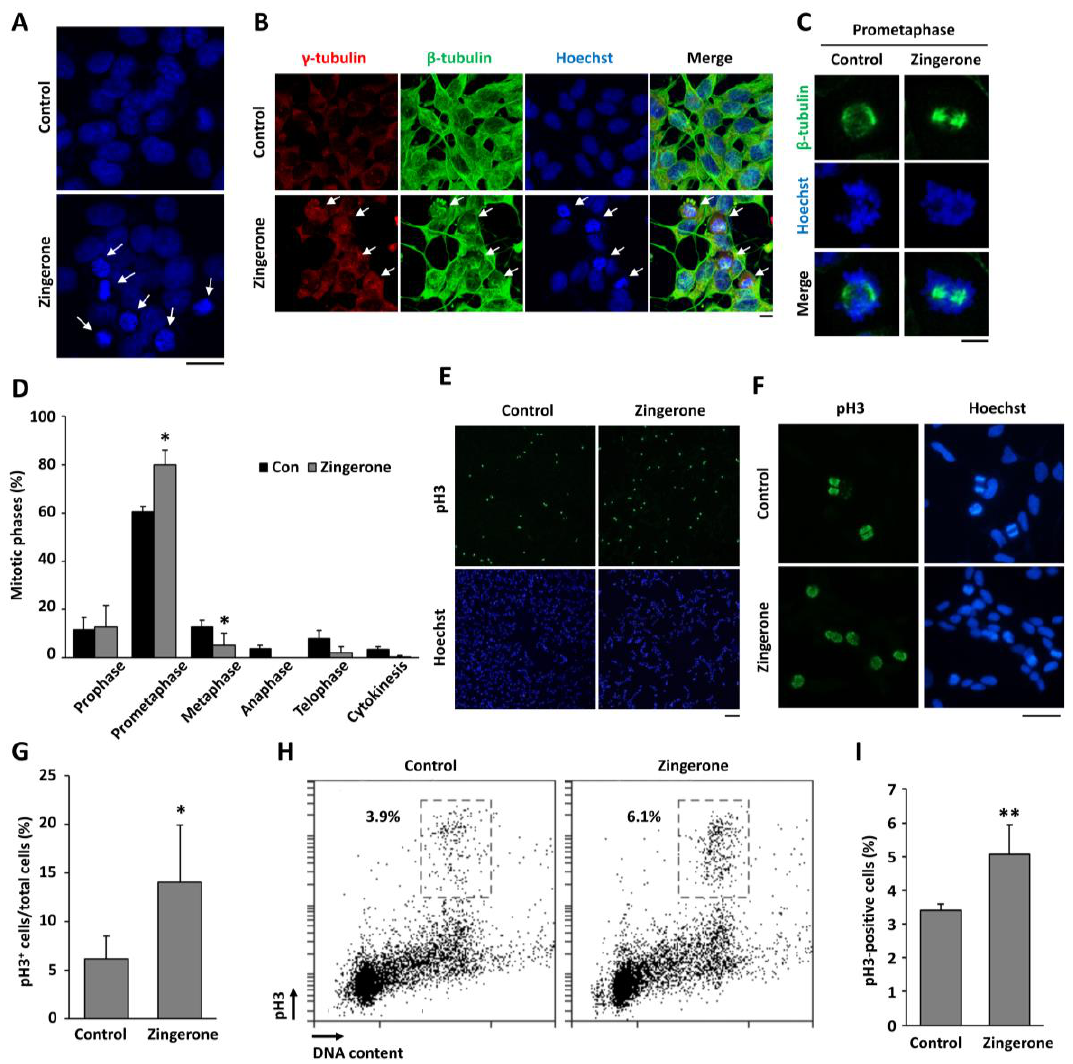
Figure 2. Effects of zingerone on cell-cycle arrest in BE(2)-M17 cells. ( A ) BE(2)-M17 cells were treated with 2 mM zingerone for 24 h. After zingerone treatment, DNA was stained with Hoechst33342 (blue). Arrows indicate condensed chromosomes. The scale bar is 20 μm. ( B ) Cell were treated with 2 mM zingerone for 24 h and then immunofluorescence staining with anti-γ-tubulin (red), β-tubulin (green), and Hoechst33342 (blue) was performed. Arrows indicate mitotic cells. ( C ) In particular, unaligned condensed chromosomes at prometaphase in control (left) and zingerone-treated (right) cells were represented. The scale bar is 5 μm. ( D ) The number of mitotic cells was counted. The data from three independent analyses are presented as the means ± SD of the mean. * p < 0.05 vs. vehicle-treated control. ( E , F ) After treatment with 2 mM zingerone for 24 h, cells were stained with anti-histone H3 phosphorylated (p)-Ser10 (pH3; green) and Hoechst33342 (blue). ( E ) The cells were observed under a fluorescence microscope. The scale bar is 100 μm. ( F ) Higher magnification of pH3-positive cells. The scale bar is 50 μm. ( G ) The pH3-positive cells were counted and quantified from three independent experiments. ( H ) DNA content and pH3-positive cells were determined by flow cytometry. ( I ) The pH3-positive cells were counted and quantified from three independent experiments. The data are presented as the means ± SD of the mean. * p < 0.05; ** p < 0.01 vs. vehicle-treated control.